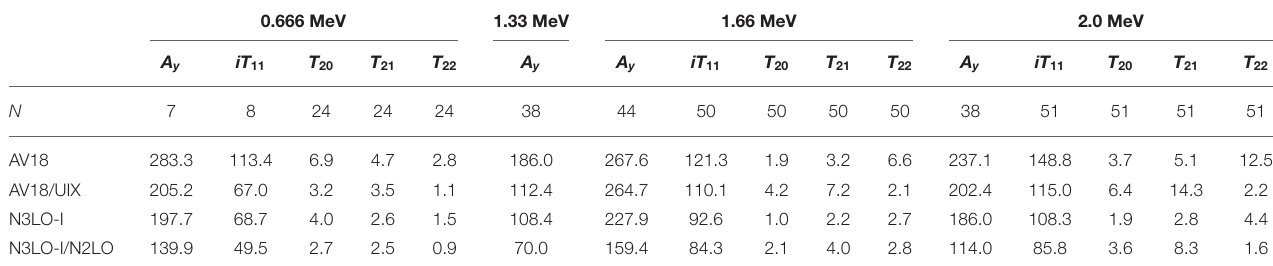
TABLE 3 | χ 2 /datum of the p − d elastic scattering observables at center-of-mass energies E c . m . = 0.666,1.33,1.66 and 2.0 MeV, calculated with the N3LO-I or AV18 two-nucleon only, and the N3LO-I/N2LO or AV18/UIX two- and three-nucleon Hamiltonian